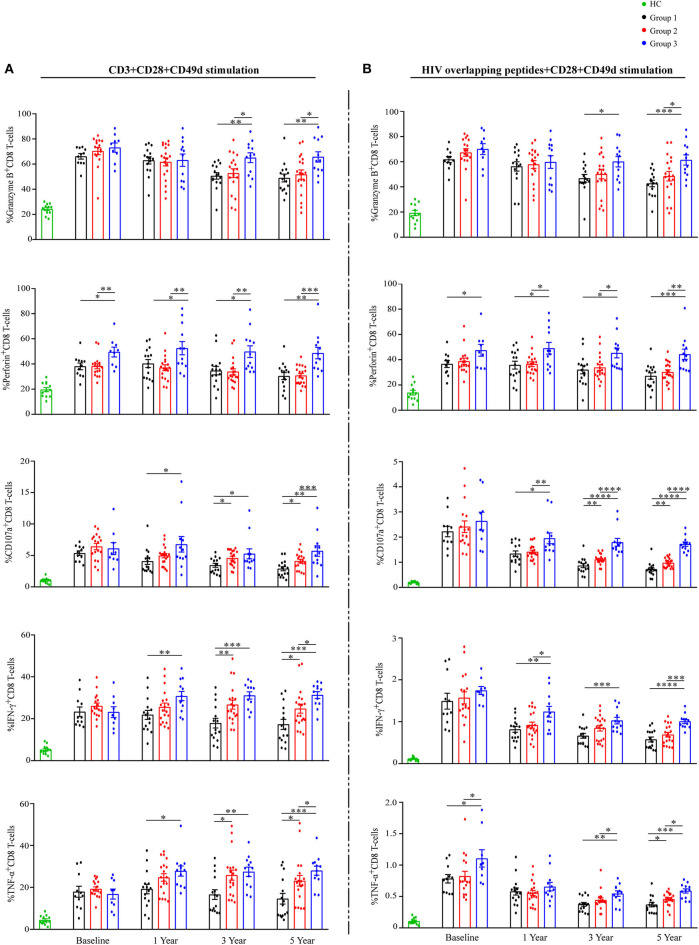
Total and HIV-specific CD8 T-cell functionalities during ART. Proportions of granzyme B, perforin, CD107a, IFN-γ, and TNF-α expression on CD8 T-cells (A) after stimulation with anti-CD3, and percentages of granzyme B, perforin, CD107a, IFN-γ and TNF-α expression on CD8 T-cells (B) after stimulation with HIV overlapping peptides show as mean ± SEM. Statistical analysis of functional markers mentioned above in three groups during ART, respectively. Group 1 (G1, n = 15 participants, 4 missing data at baseline), Group 2 (G2, n = 19 participants, 2 missing data at baseline), Group 3 (G3, n = 12 participants, 3 missing data at baseline), HC (health controls, n = 12 participants). *P < 0.05, **P < 0.01, ***P < 0.001, ****P < 0.0001.